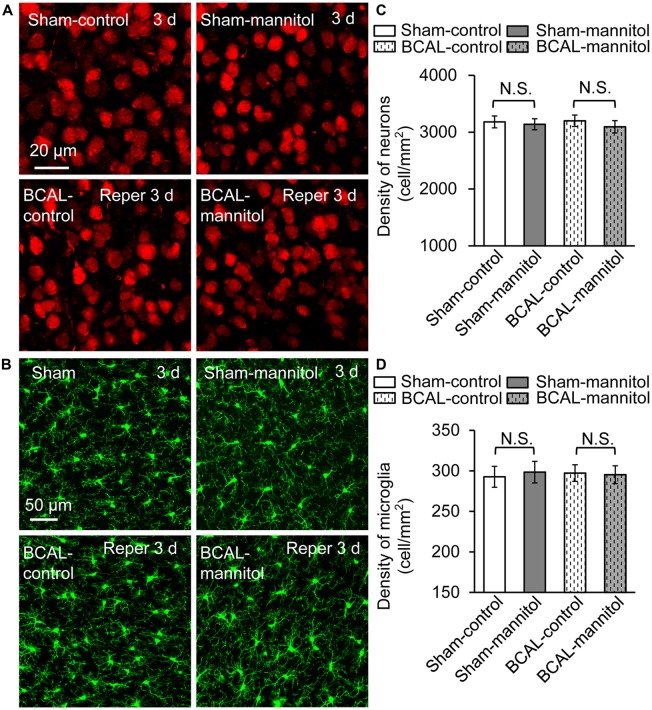
Mannitol did not affect the densities of neurons or microglia after ischemia. (A) Representative confocal images of the neurons (red) in different groups. (B) Confocal images showing the morphology of microglia (green) in different groups. (C) Quantification of neuronal density showing that there is no significant difference in different groups (n = 6 mice, each group. N.S., p > 0.05). (D) The density of microglia was not changed after transient ischemia and/or mannitol treatment (n = 6 mice, each group. N.S., p > 0.05).